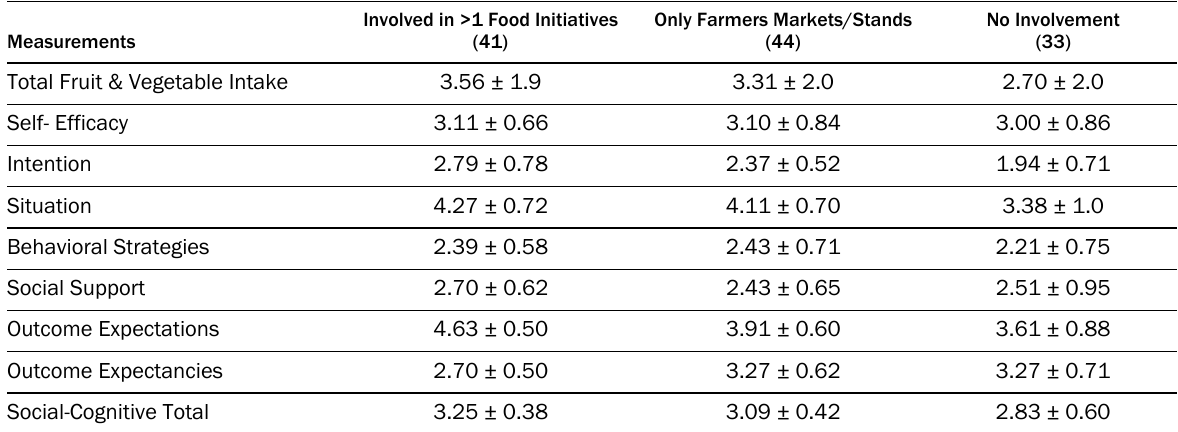
Table 5. Social-Cognitive Dietary Questionnaire Scores and Fruit and Vegetable Intake Among Participation in